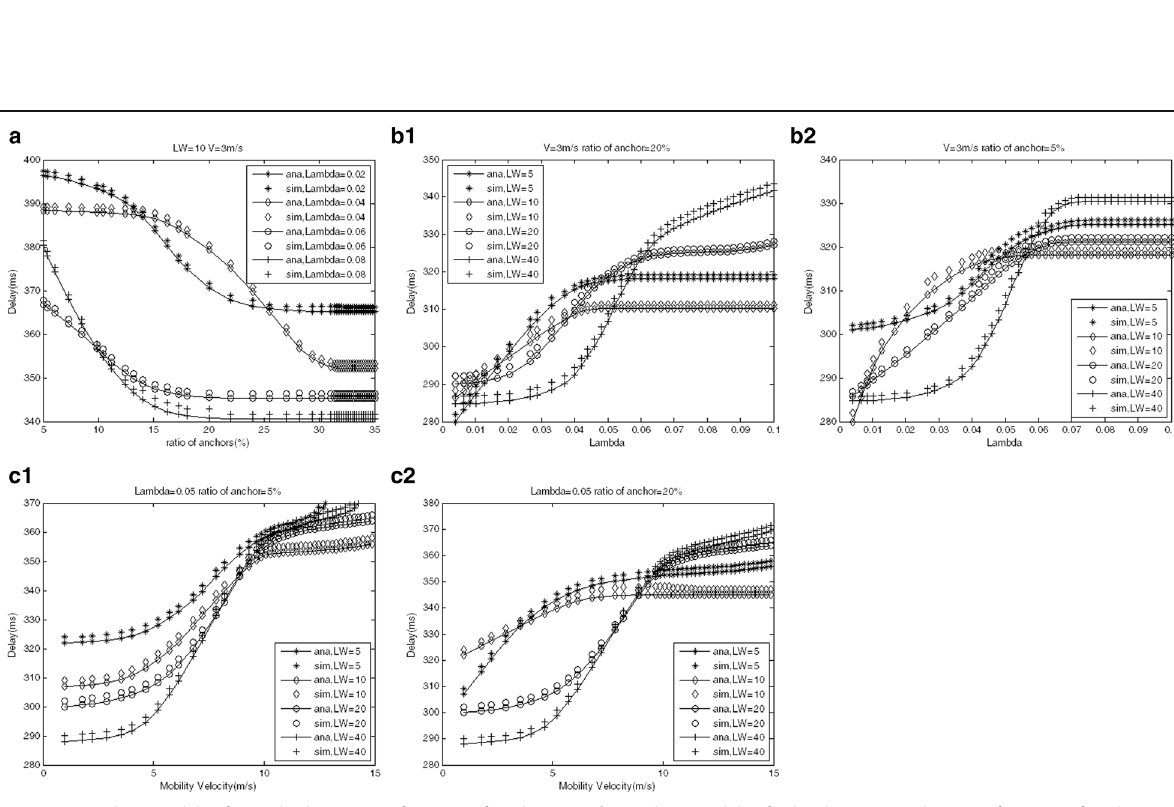
Fig. 8 a Localization delay for node density as a function of anchor ratio. b Localization delay for localization window as a function of node density. c Localization delay for localization window as a function of mobility